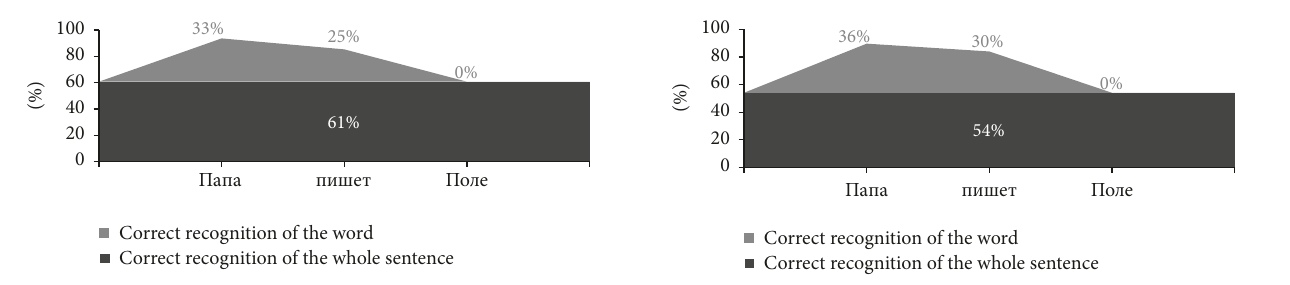
Figure 15: Recognition of isolated words in the phrase « ^1_1 _Ke e g ^]S e» (Eng.: Father writes to Polya) against white noise [Base: 𝑛 = 252 ].